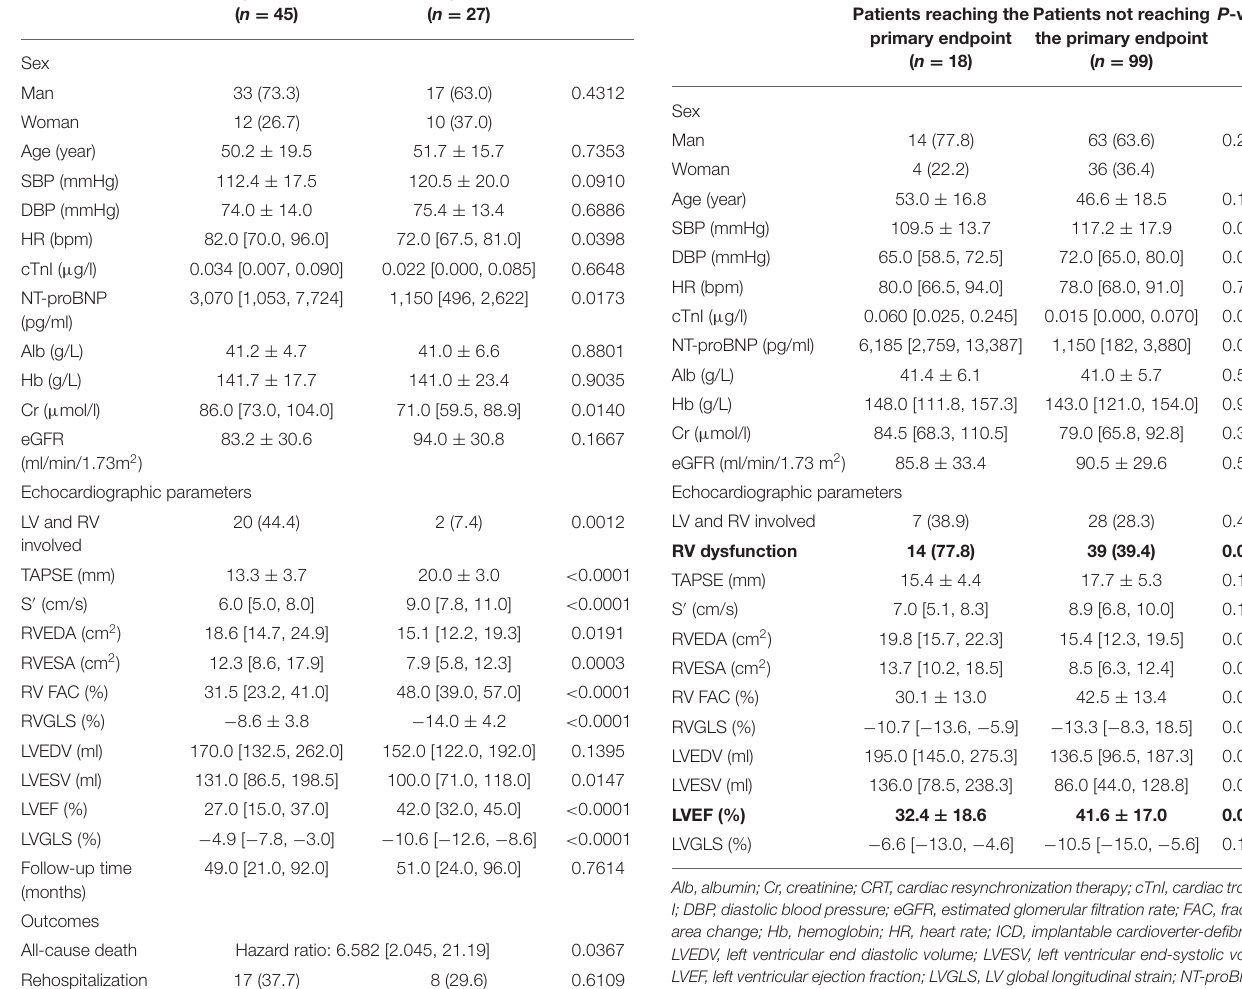
not reaching the primary endpoint. Patients reaching the primary endpoint